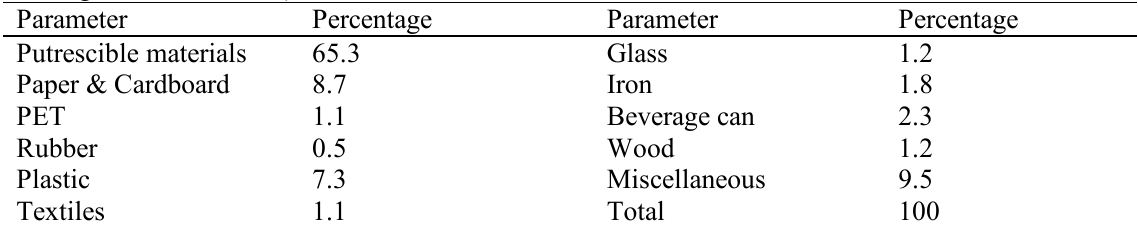
Table 1 . Physical analysis of Babol's MSW (Babol's Comprehensive Waste Management Plan, 2017) Parameter Percentage Parameter Percentage Putrescible materials 65.3 Glass 1.2 Paper & Cardboard 8.7 Iron 1.8 1.1 Beverage can 2.3 0.5 Wood 1.2 Plastic 7.3 Miscellaneous 9.5 Textiles 1.1 Total